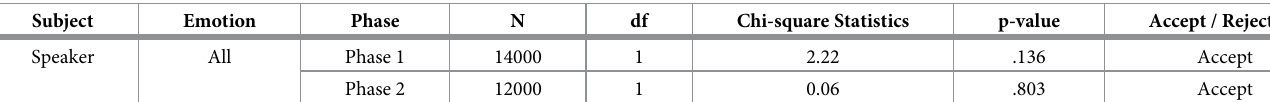
Table 26. Chi-square statistics for speaker